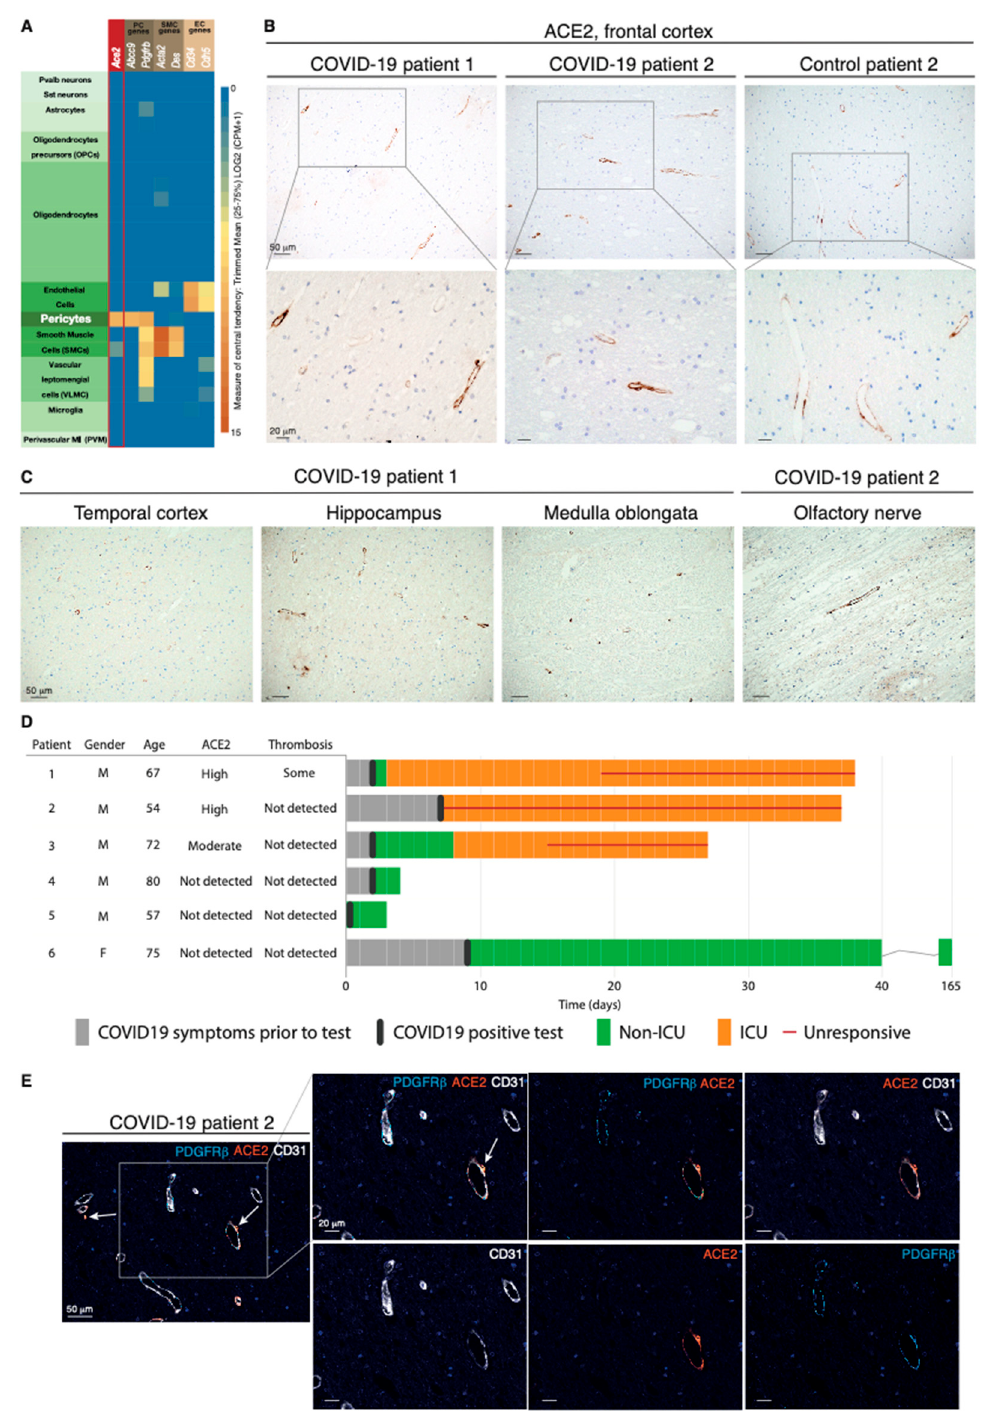
Figure 1. The ACE2 receptor is expressed by pericytes in murine and human brains. ( A ) Expression of Ace2 in cell types in the mouse brain; cell types are annotated based on the Allen Mouse Brain Atlas. ( B ) Representative IHC staining of perivascular ACE2 in the frontal cortex of two COVID-19 patients and one control individual. Cell nuclei are counterstained with hematoxylin (blue). ( C ) Representative IHC staining of perivascular ACE2 in different brain regions of the two COVID-19 patients in subfigure B. Cell nuclei are counterstained with hematoxylin (blue). ( D ) Clinical course of the COVID-19 patients included in the study. For each patient, appearance of symptoms, hospitalization, infection status, and